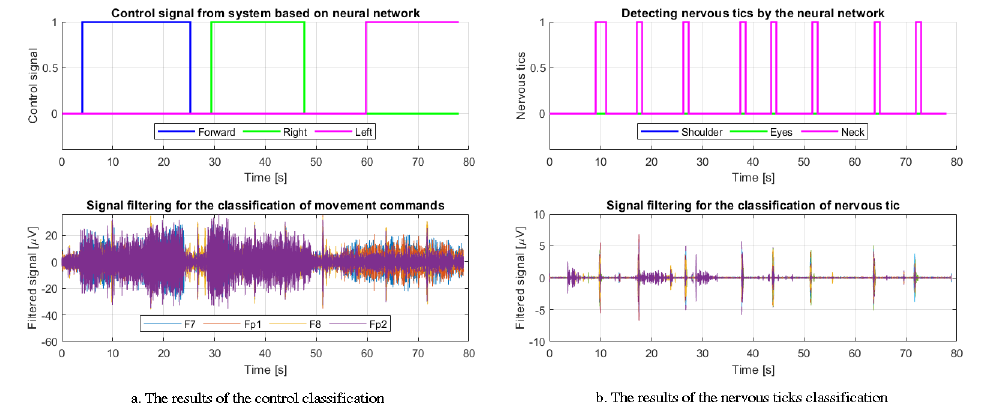
Figure 22. An example of the classification of movement commands and nervous tics—neck mus- cles